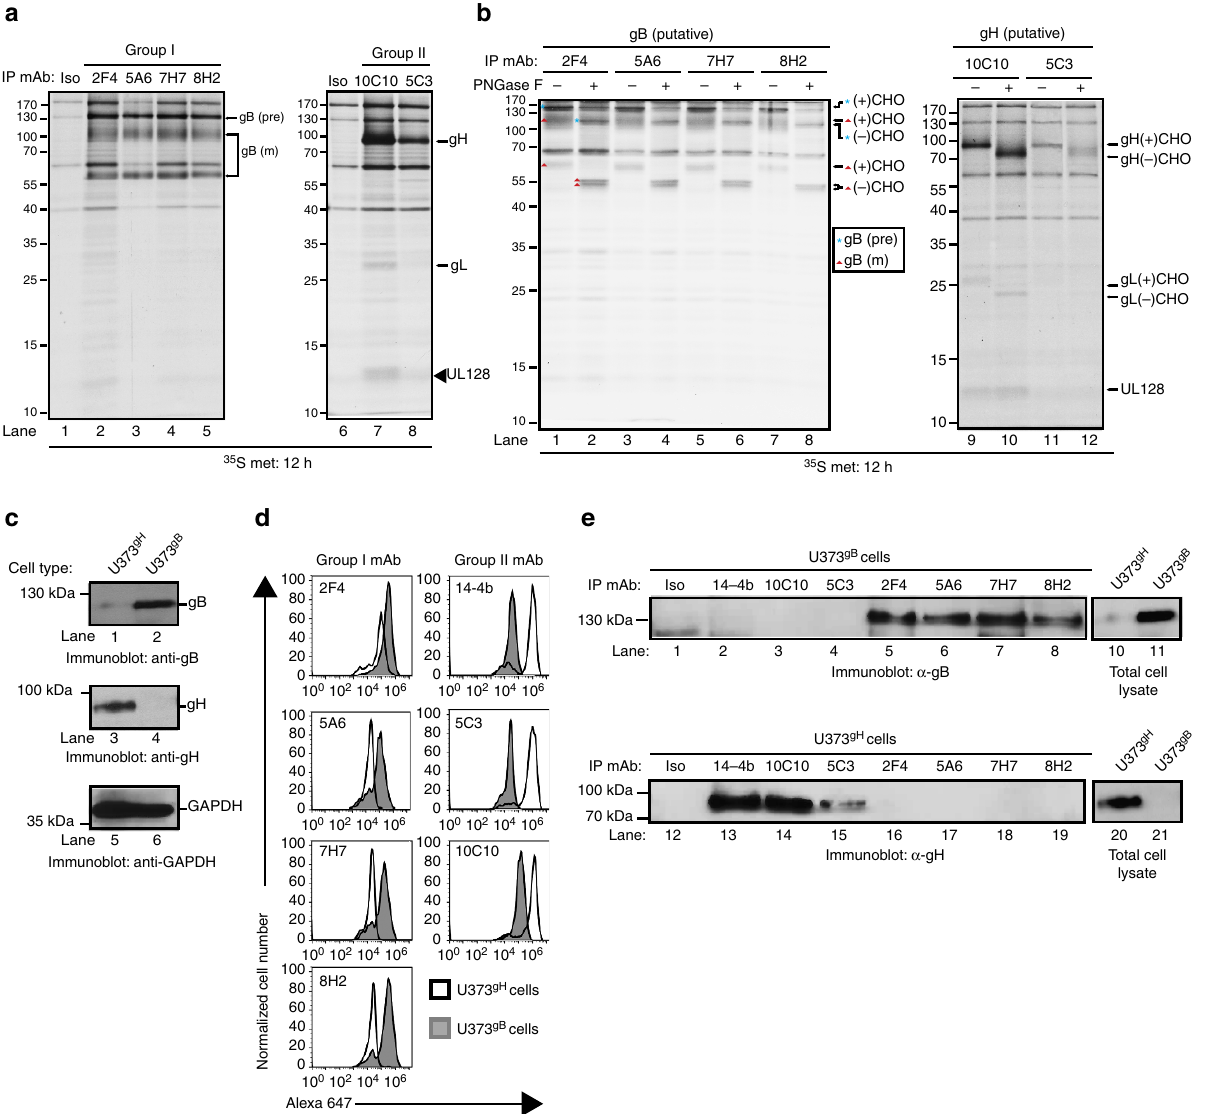
Figure 2 | Identification of CMV-neutralizing mAb targets ( a ) Lysates from metabolically labelled AD169 IE2-YFP -infected MRC5 cells were exposed to the CMV-neutralizing mAbs and recovered immune complexes were resolved by SDS–PAGE. Arrows denote the suspected peptide identity. ( b ) Immune complexes recovered from the metabolically labelled cell lysates were exposed to PNGase treatment and resolved by SDS–PAGE. Arrows denote the suspected peptide identity and glycosylation state. ( c ) Total cell lysates from U373 glioblastoma cells stably expressing gH (U373 gH ) or gB (U373 gB )